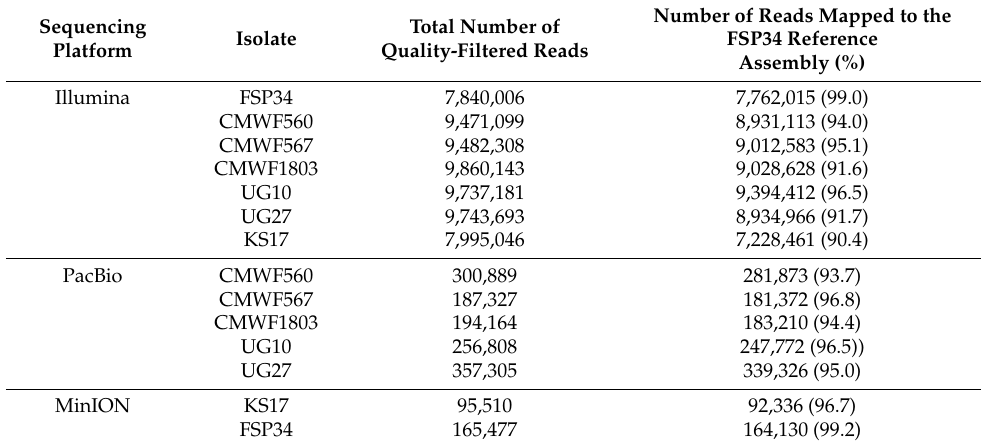
Table 3. Summary statistics for number of reads obtained and mapped to each genome for the different sequencing platforms.